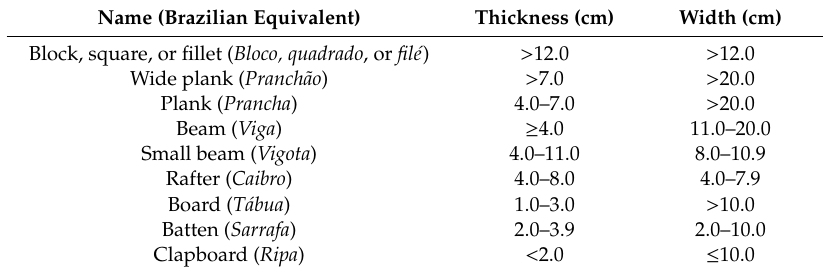
Table 1. Classification of sawn wood as defined by Resolution no. 474 of 6 April 2016 [53]. Name (Brazilian Equivalent) Thickness (cm) Width (cm) Block, square, or fillet ( Bloco, quadrado , or fil é ) > 12.0 > 12.0 Wide plank ( Pranch ã o ) > 7.0 >